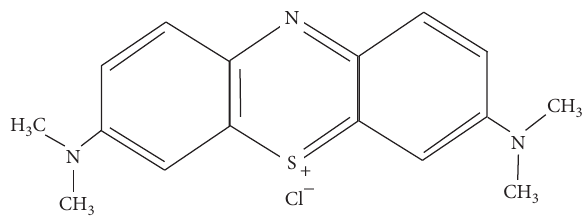
Figure 1: Chemical structure of methylene blue